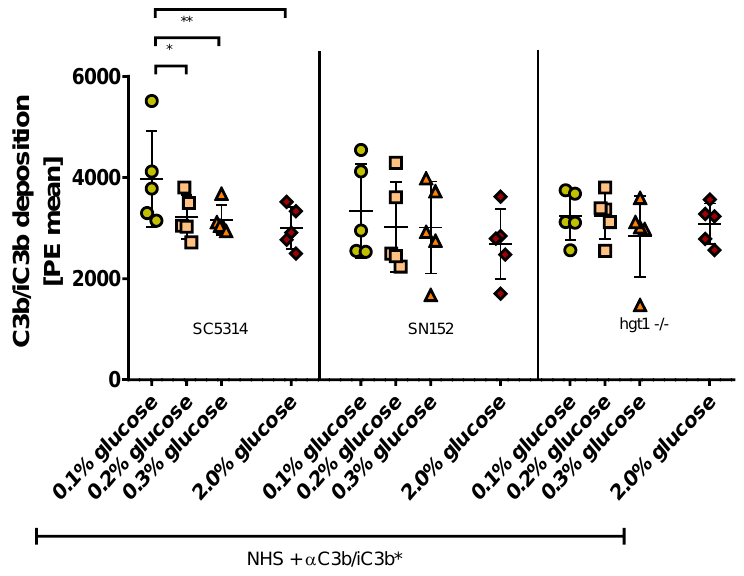
Figure 3. C3b/iC3b deposition on the surface of Candida albicans yeast cells incubated overnight at different glucose concentrations. Yeast cells of wild type (SC5314), parental (SN152), and HGT1 knockout (hgt1-/-) strains were incubated in yeast peptone medium with either 0.1%, 0.2%, 0.3%, or 2% glucose and opsonized with 10% normal human serum (NHS). A specific anti C3b/iC3b antibody (αC3b/iC3b) was used and the deposition was measured using fluorescence-activated cell sampler (FACS) Verse with BD software. The deposition of C3b/iC3b is shown in phycoerythrin (PE) mean. The results shown were gained by five independently performed experiments (mean ± SD). Stars (*) indicate the level of significance for an adjusted p -value, comparing pairs of groups using a Tukey post-hoc analysis after the one-way ANOVA reported significance.